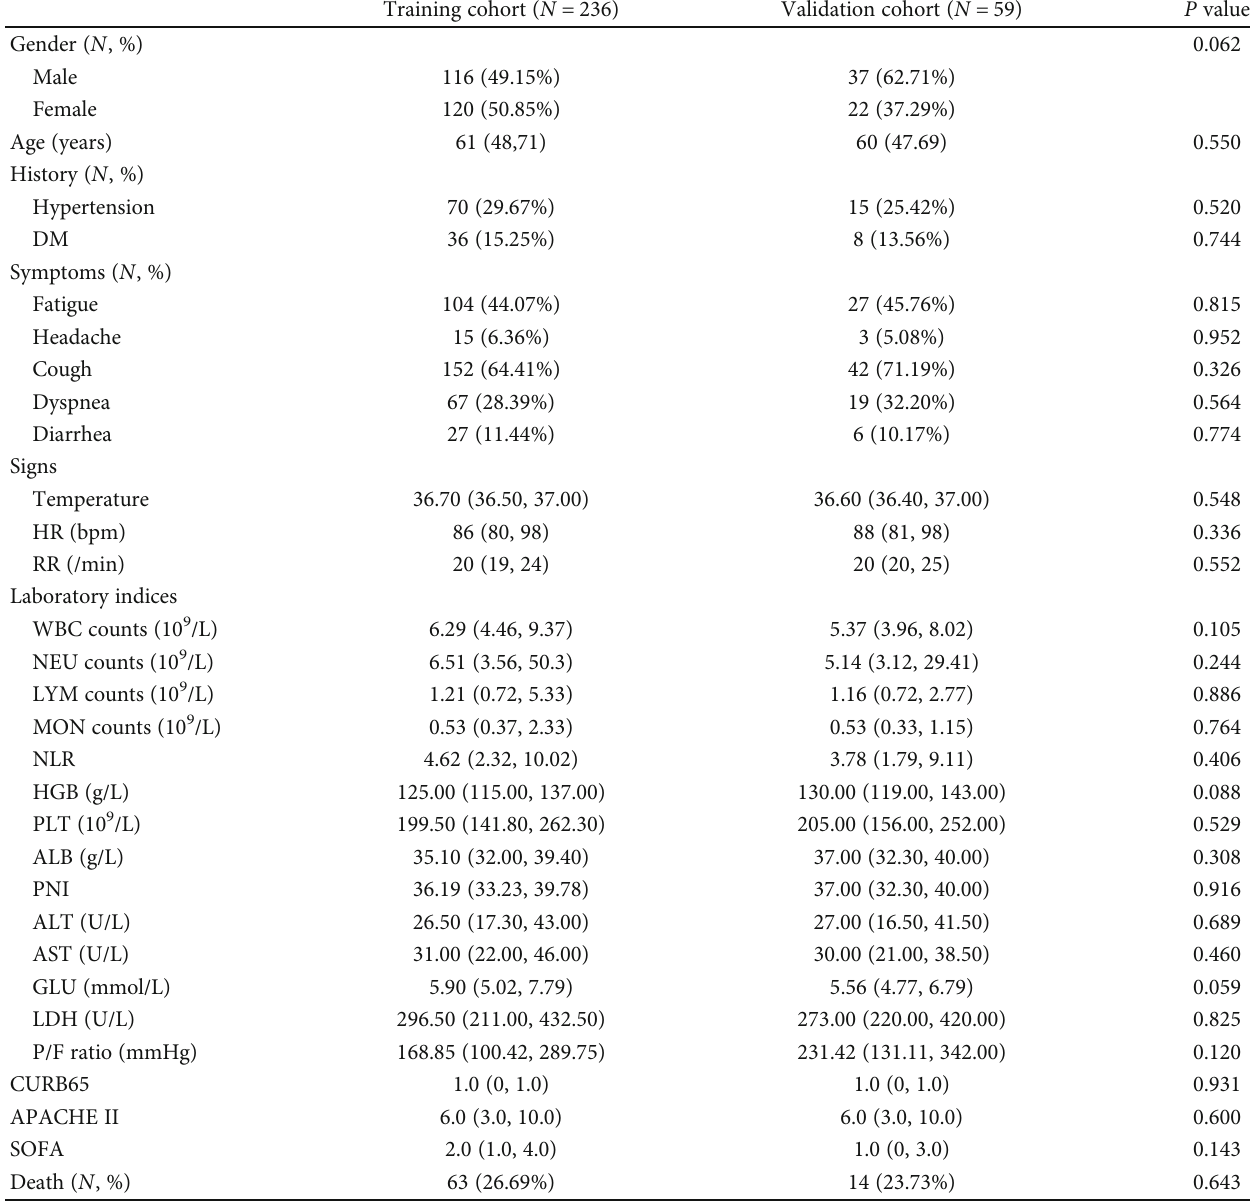
Table 1: Clinical characteristics of patients with COVID-19 in the training and validation